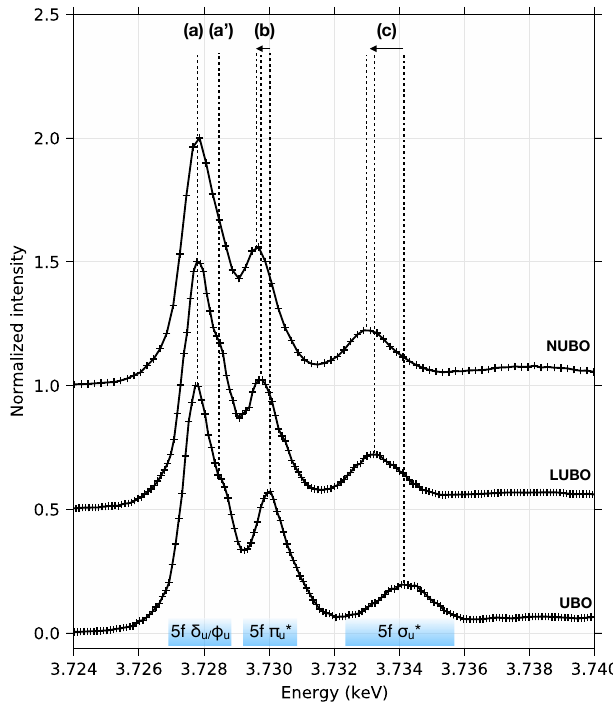
Figure 4. HERFD-XANES spectra at the U M 4 -edge, from UBO (bottom) to NUBO